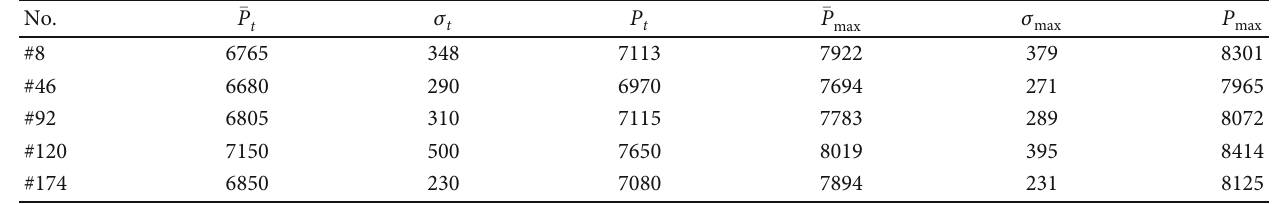
Table 1: Judgment criteria for the fi rst weighting in some hydraulic supports.